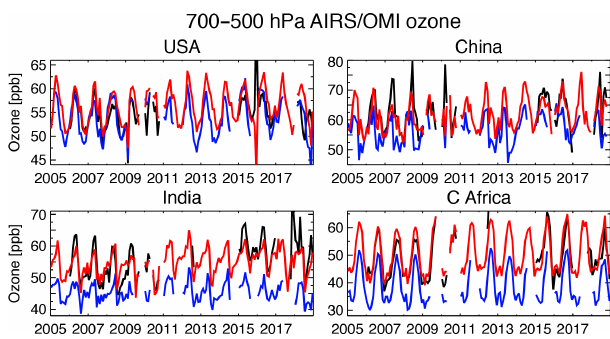
Figure 3. Time series of the monthly mean ozone concentration ob- tained from the AIRS/OMI retrievals (black), control run (blue), and reanalysis (red) averaged between 700–500hPa over the US